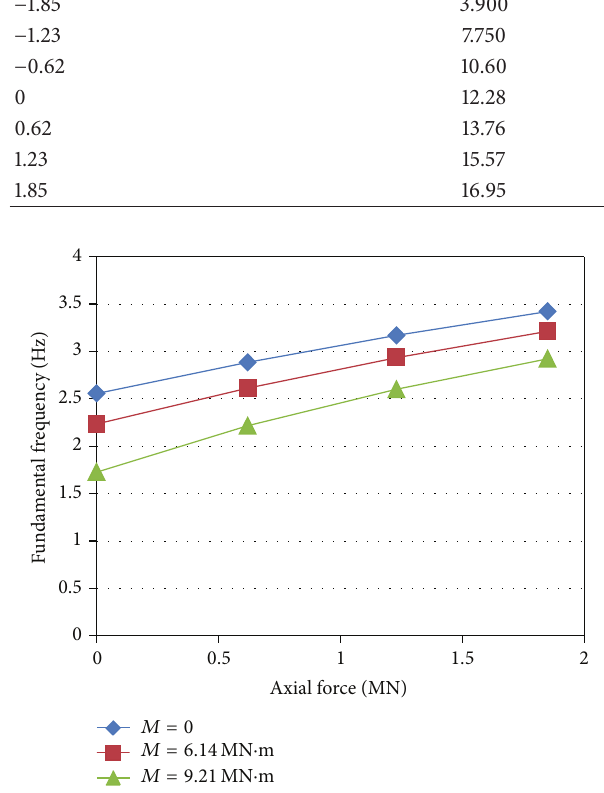
Figure 4: Variation of the fundamental frequency with tensile force and end moment; cantilevered (C-F) boundary